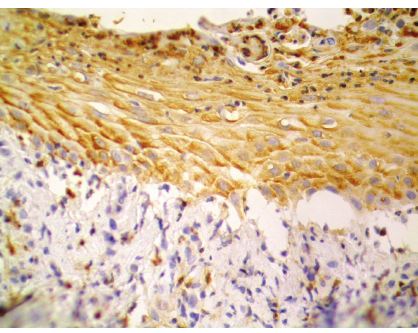
Figure 1: Expression of TF in epidermis and cells of influx. Skin lesions. Bullous pemphigoid. 400x Immunohistochemistry.